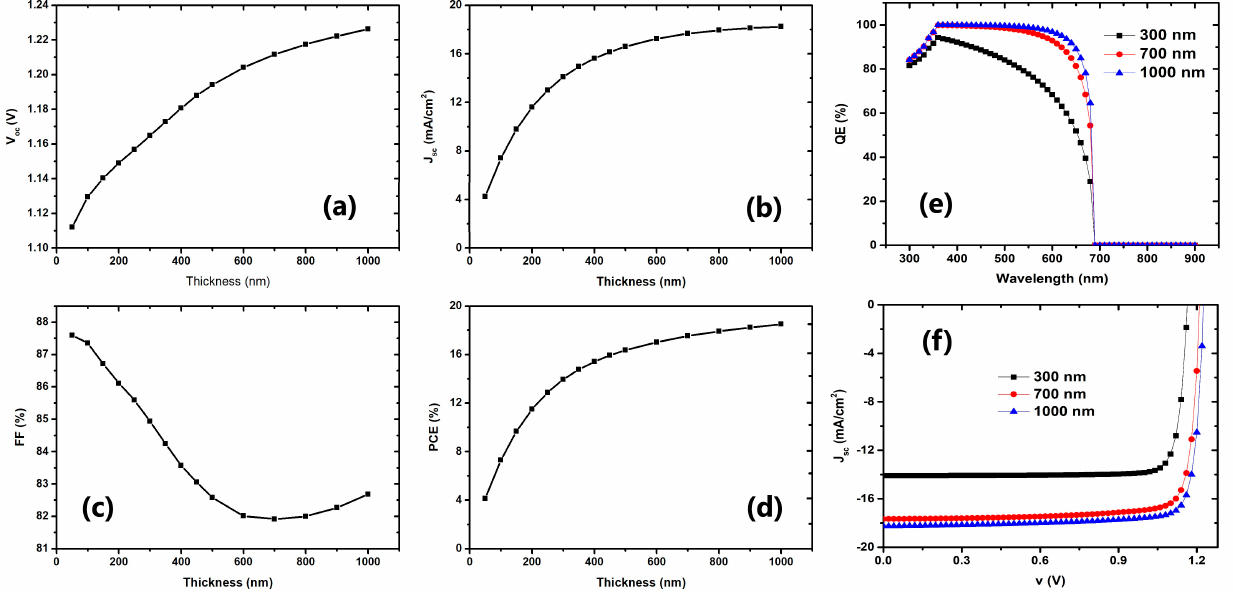
Figure 6. ( a – d ) Influence of varying C 2 N thickness on PV parameters. ( e , f ) QE and J-V behavior with varied C 2 N thickness.